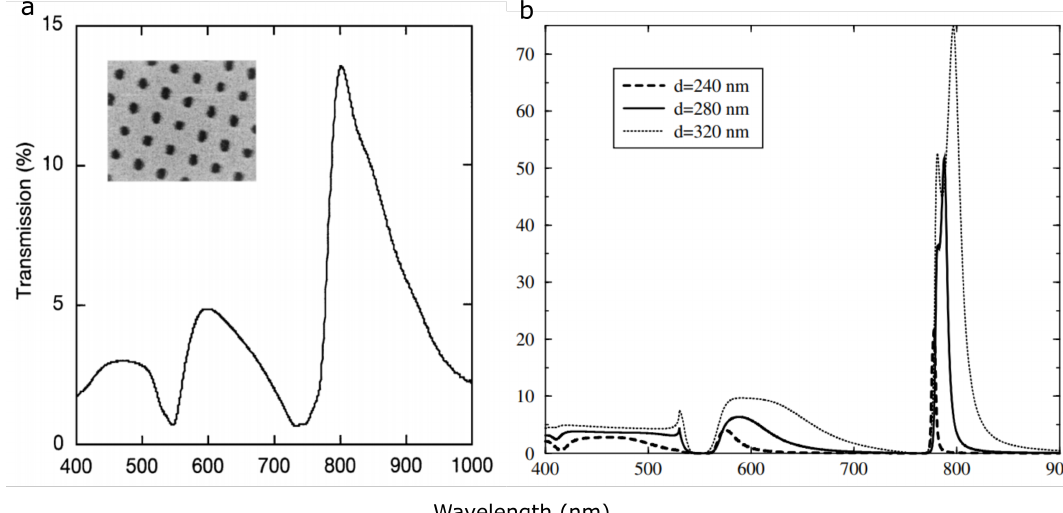
Figure 8. ( a ) Experimental and ( b ) theoretical plots of the normalised transmittance as a function of the incident light wavelength, for a square array of holes on a Ag thin film with thickness h = 320 nm. The diameter of the holes was d = 280 nm in the experiment and d = 240,280,320 nm for the calculations and the lattice constant 750 nm. Inset in the left plot shows an SEM image of the nano-hole lattice. Image reproduced with permission from